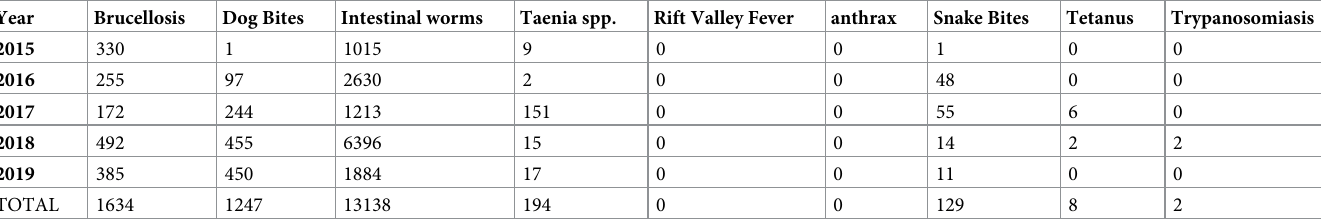
Table 6. Zoonotic Diseases reported in the District Health Information System, Nakuru West Sub County,